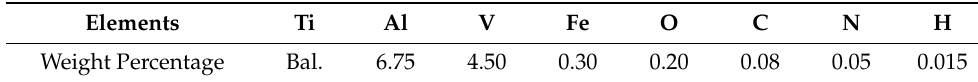
Figure 1. Schematics of specimen preparation. Table 2. Composition in wt. %.